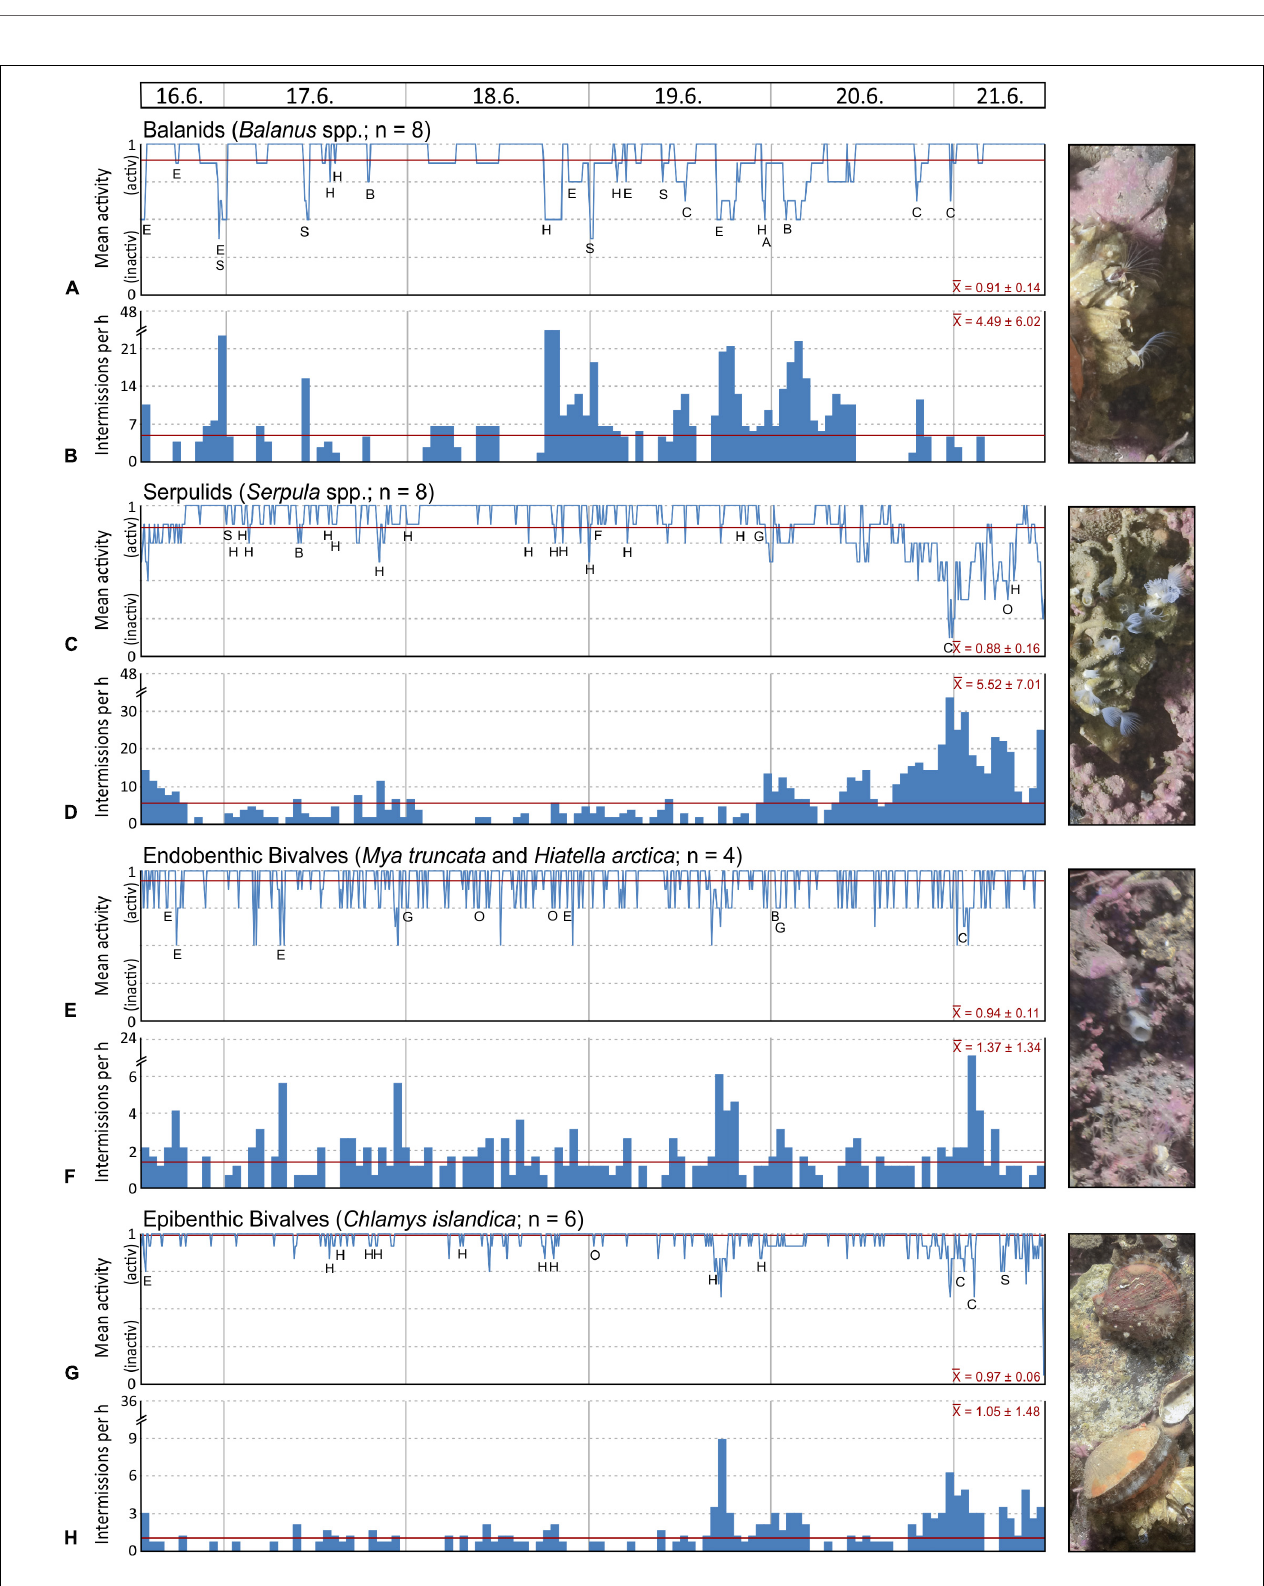
FIGURE 13 | Mean filter-feeding activity and cumulative intermissions in activity per hour of selected benthos organisms, as observed on images of the lander’s camera system during the 6 days of deployment in Mosselbukta: balanids (A,B) , serpulids (C,D) , endobenthic bivalves (E,F) , and epibenthic bivalves (G,H) . Abbreviations used for indicating disturbances: E, echinoid; O, ophiuroid; A, asteroid; C, crab; S, shrimp; H, hermit crab; B, bivalve; G, gastropod; F, fish.